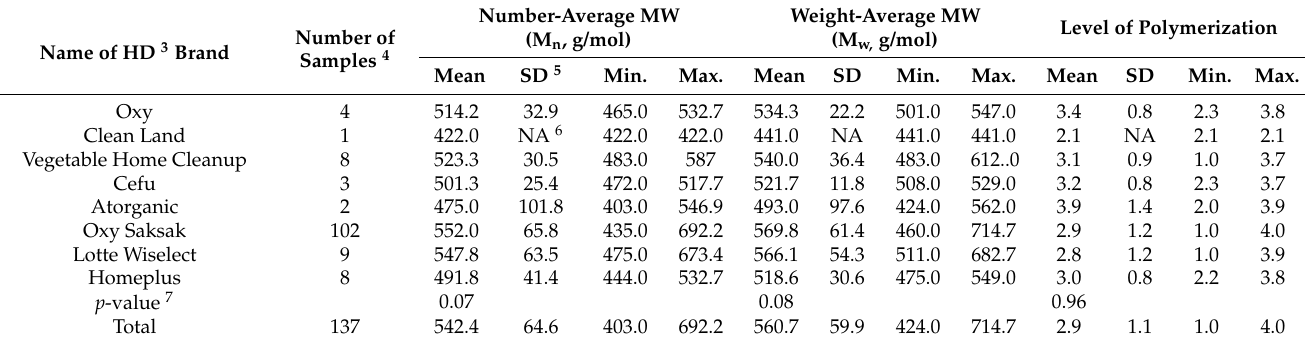
Table 1. Number-average (M n ) and weight-average (M w ) molecular weights of PHMG 2 by brand 1 .